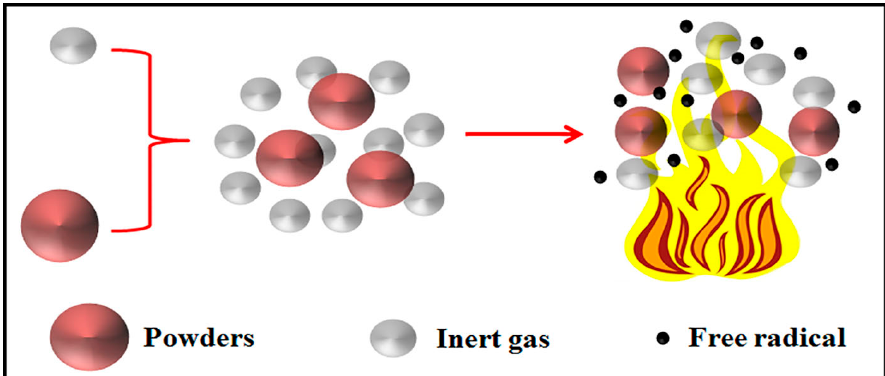
Figure 7. The inhibition mechanism diagrammatic sketch of the gas–solid two-phase inhibitors.